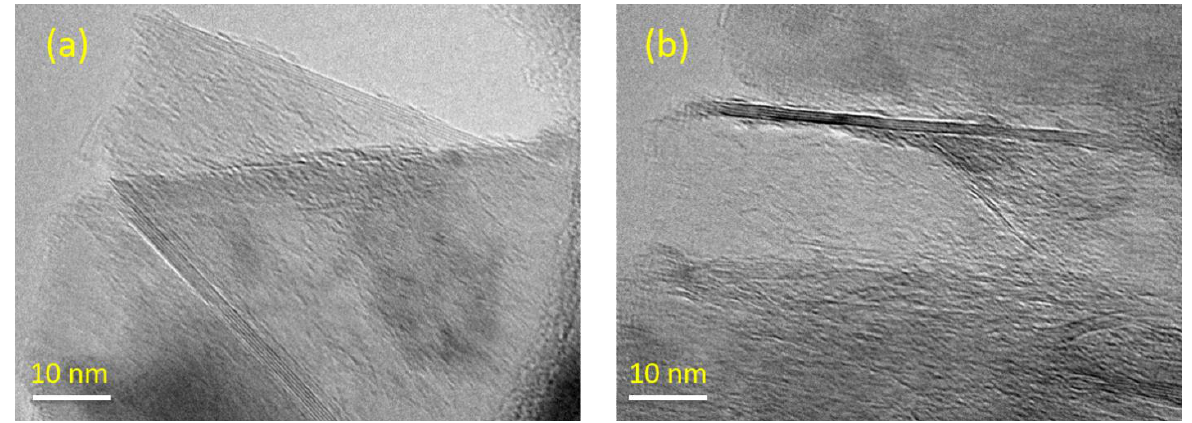
Figure 2. TEM images of Gr0X ( a ) and Gr3X ( b ).